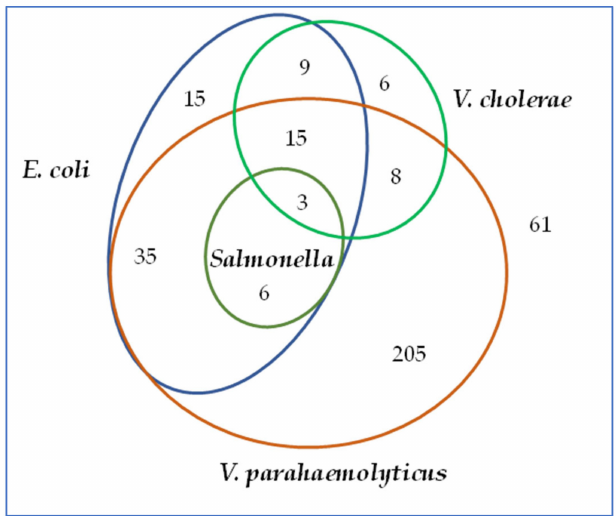
Figure 4. The presence of E. coli , Salmonella , V. parahaemolyticus , and V. cholerae in coastal water samples (n = 363) from oyster production regions in